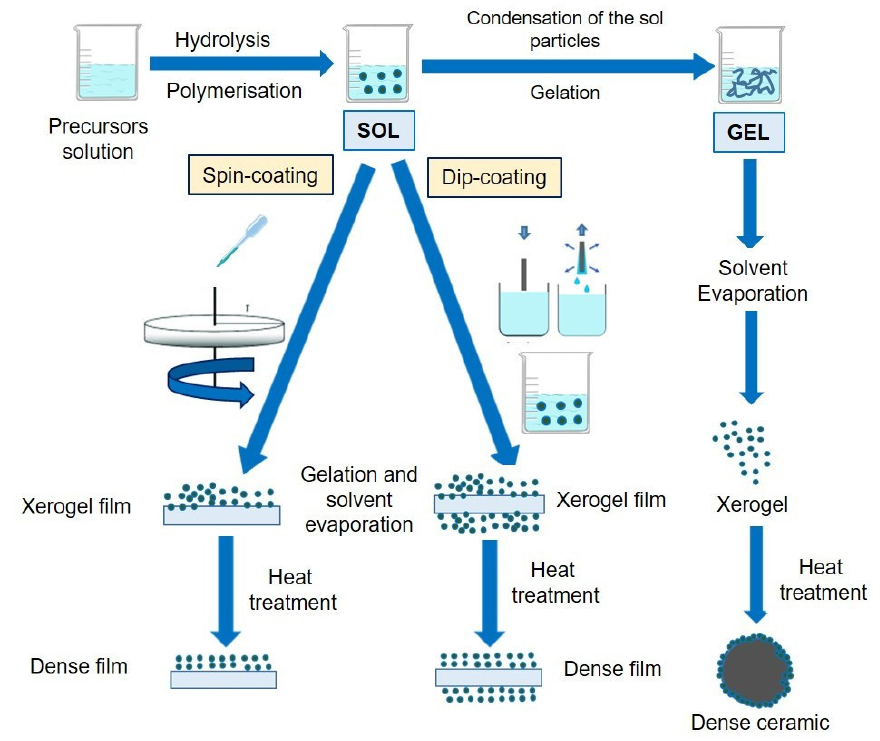
Figure 1. Schematic representation of the typical sol-gel route.